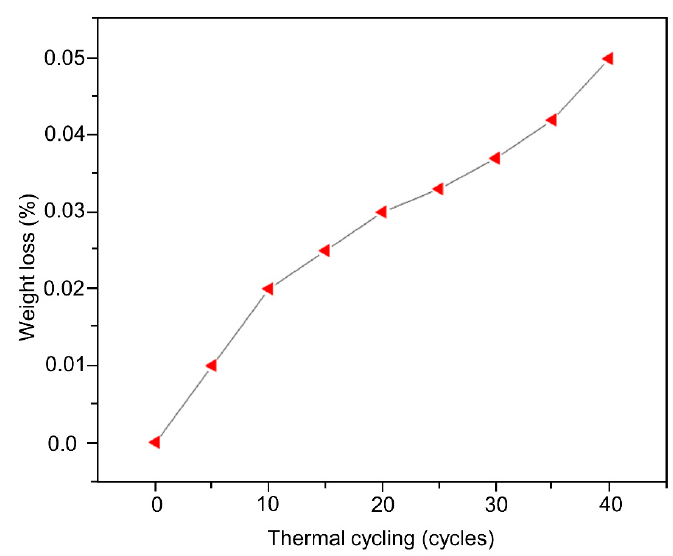
Figure 10. Thermal cycling oxidation curves of the MoSi 2 -Si 3 N 4 / SiC coating between 1773 K and room temperature.